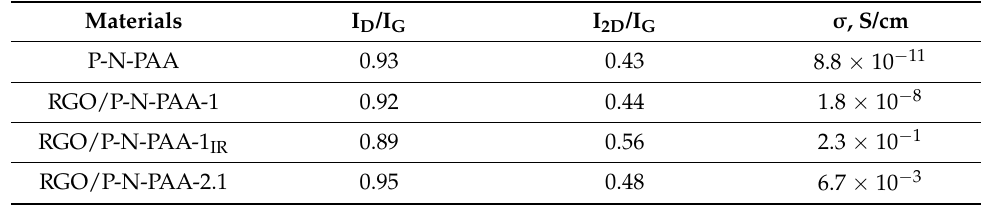
Table 2. The conductivity values of